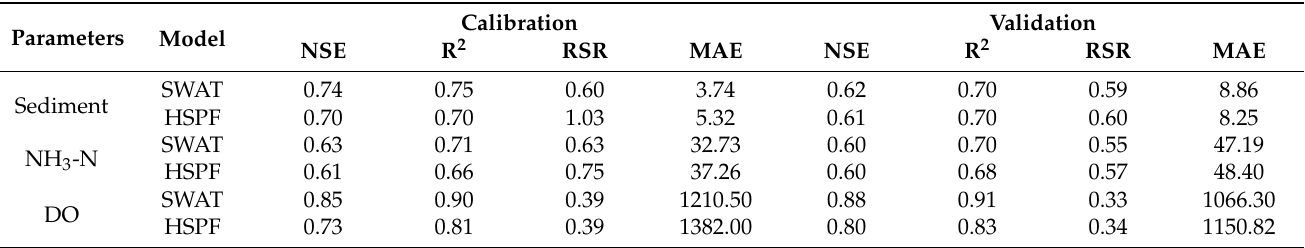
Table 5. Summary of the water quality simulation indices used to evaluate the SWAT and HSPF models.